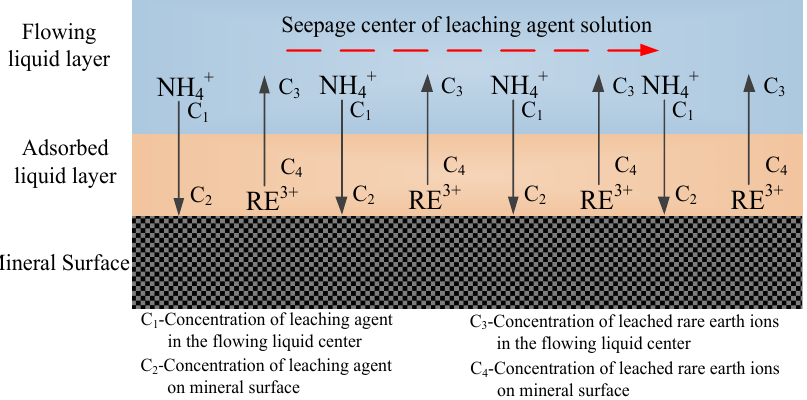
Figure 8. Schematic diagram of mass transfer process of ionic rare earth ore. As the reaction is carried out on the surface of clay minerals, the concentration of leaching agent on the mineral surface decreases due to reaction consumption, and the concentration of a leaching agent in the flowing liquid layer, far away from the reaction zone, is high. On the contrary, the reaction product (RE 3+ ) is the largest near the mineral surface, while the concentration of the flowing liquid layer is low. The concentration difference between the flowing liquid layer and the reaction interface promotes the migration of reactants and leaching agent at the phase interface, and realizes the mass transfer process of leaching agent cations from solution to solid phase and rare earth ions on clay surface from solid phase to mobile liquid phase [48,54,55]. Scholars have found that the leaching process of ionic rare earth ore can be regarded as the color layer leaching process. The theoretical tray height reflects the mass transfer effect. The greater the theoretical tray height is, the stronger the lateral diffusion effect is, the worse the leaching mass transfer effect is. The theoretical tray height and the influencing factors of leaching can be described by the van Deemter equation (Equation (5)), and a theoretical tray height curve with leaching operation parameters is shown in Figure 9 [48].